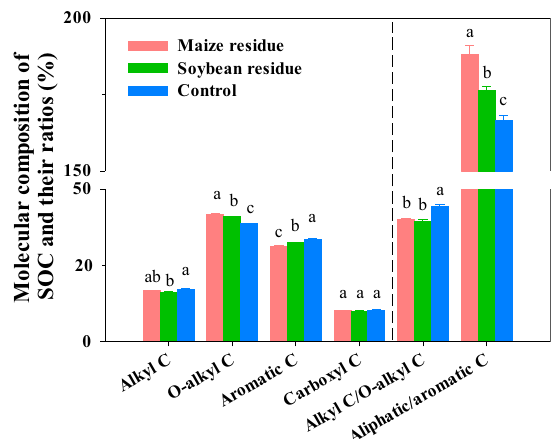
Fig. 2 Chemical composition of soil organic C (SOC). The relative proportions (%) of different functional groups of SOC in response to the amendment of maize and soybean residues after incubation at 25 °C for 250 days. Different letters above bars indicate signi fi cant differences among treatments at p < 0.05 (one-way ANOVA). Error bars were the standard error of three